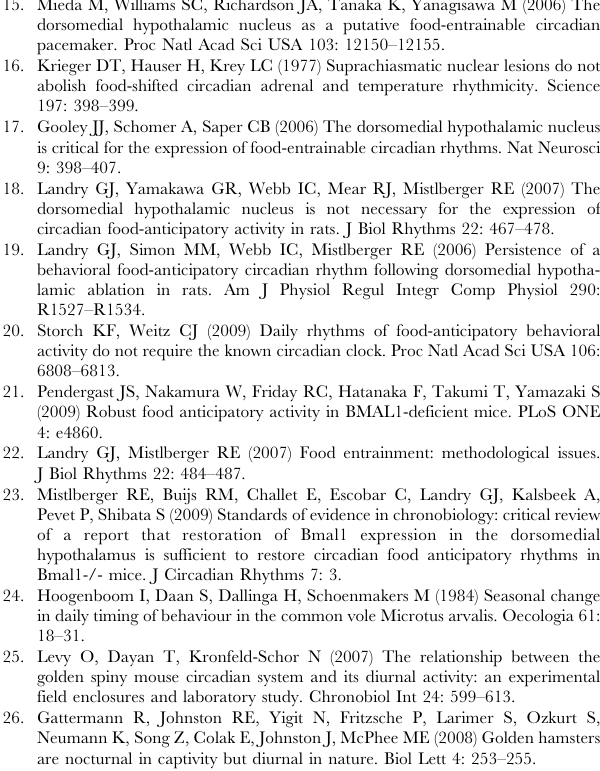
nocturnal mouse activity into the day’.